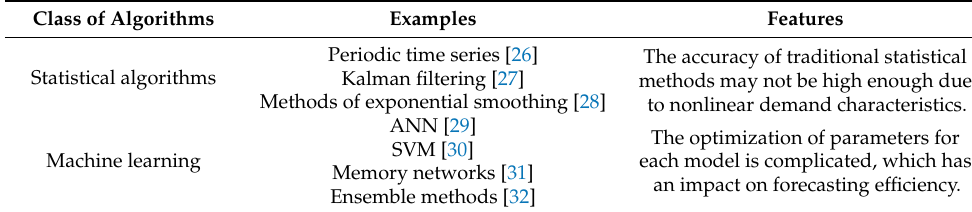
Table 1. Comparison of load prediction